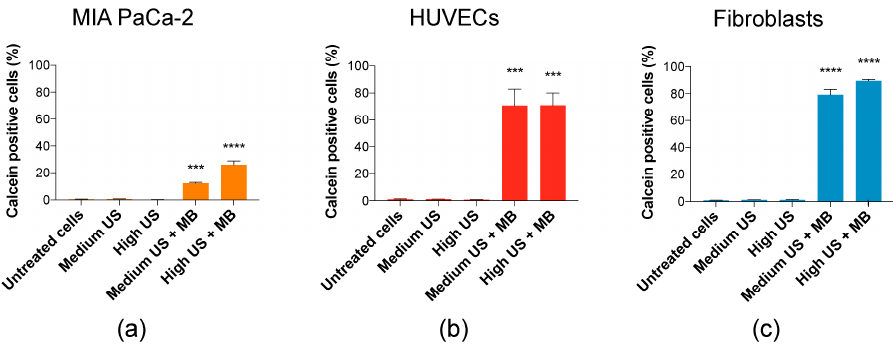
Figure 2. The percentage of cells taking up calcein. Addition of MBs was necessary for increased uptake in cells. ( a ) In MIA PaCa-2, increased US intensity increased the percentage of calcein-positive cells. ( b ) In human umbilical vein endothelial cells (HUVECs), increased US intensity was not important for percentage of calcein-positive cells. ( c ) In fibroblasts, increased US intensity resulted in a small increase in percentage of calcein-positive cells. Mean ± SEM; *** p < 0.001, **** p < 0.0001 (treated vs. untreated